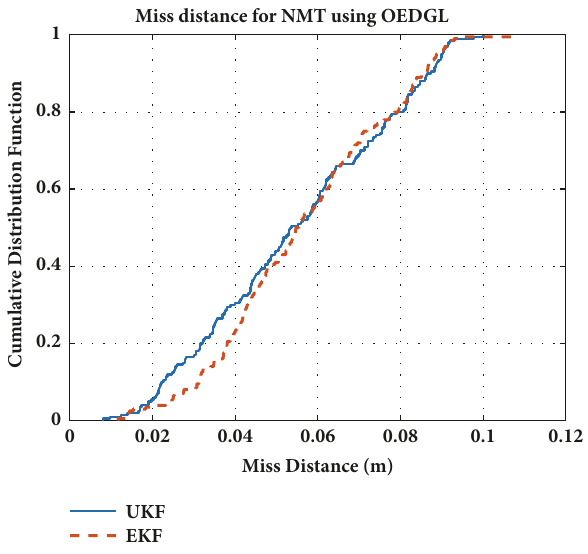
Figure 10: Miss distance CDF for NMT.